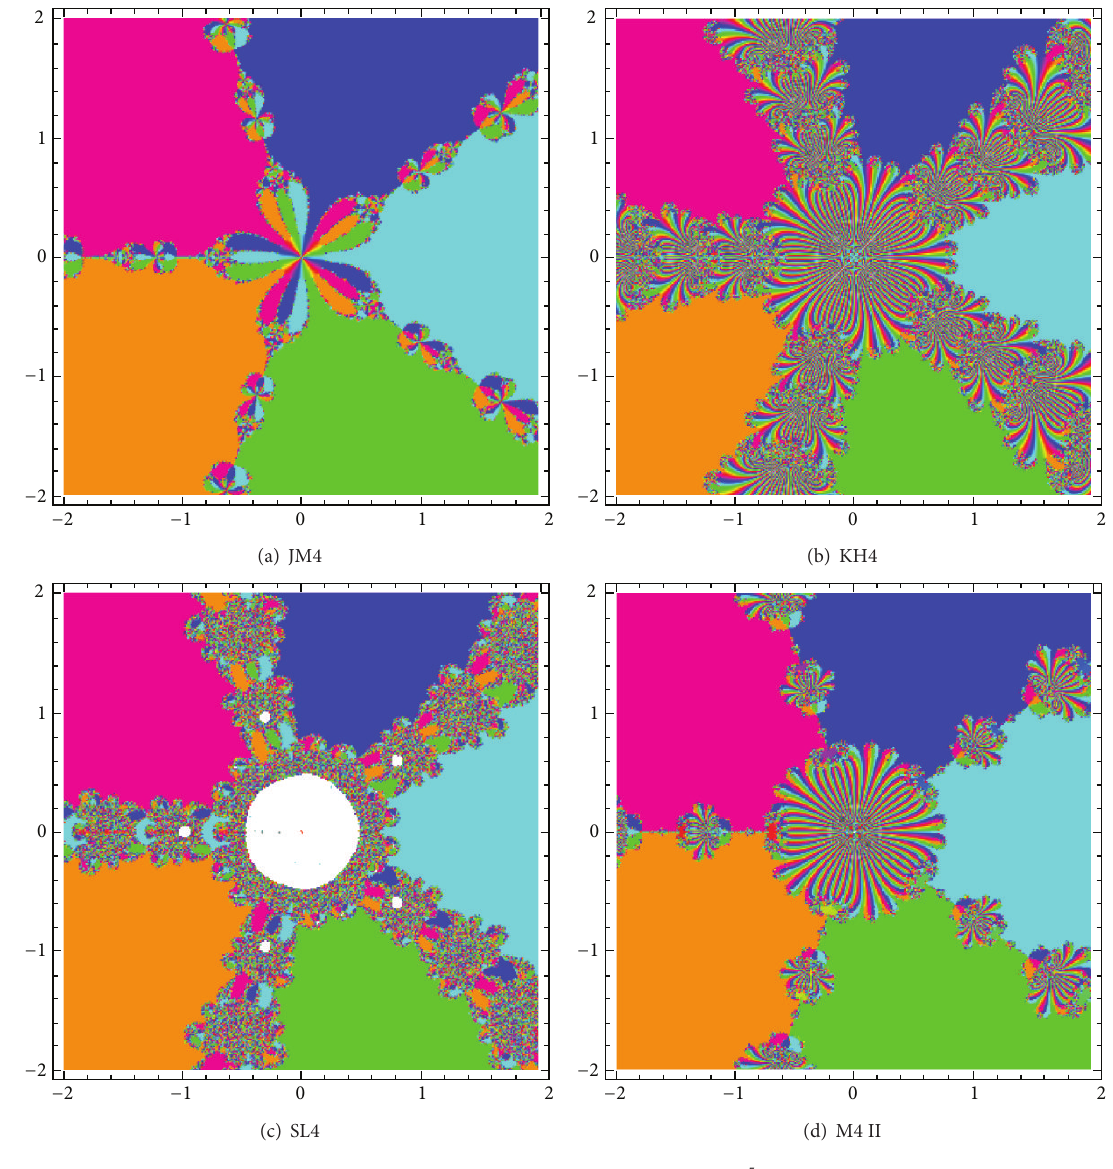
Figure 4: Basin of attraction for polynomial 𝑧 5 − 1